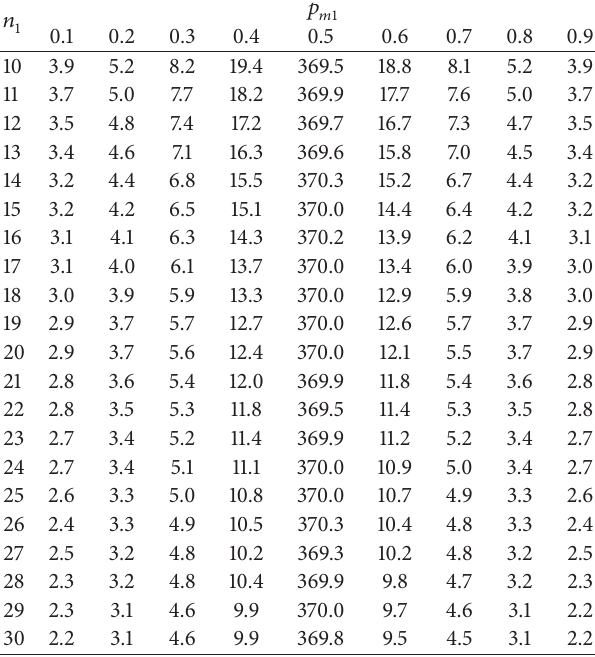
Table 4: The ARL 𝑚1 of the EWMA-AM chart ( 𝜆 1 = 0.05 , 𝑝 𝑚0 = 0.5 with ARL 𝑚0 ≈ 370 ).